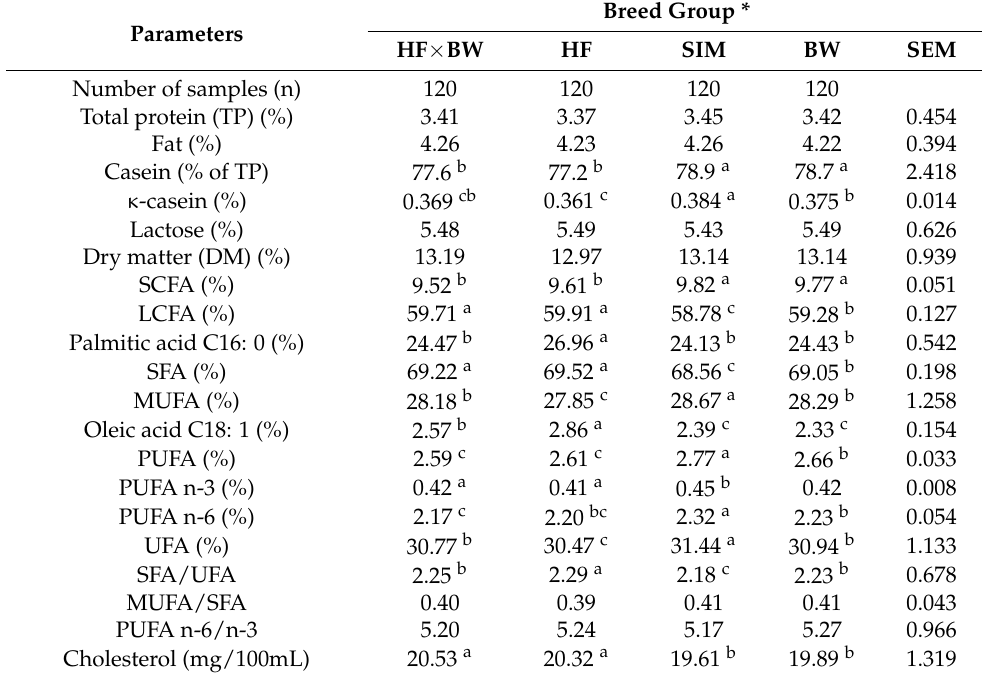
Table 3. Content of nutrients and main fatty acid fractions in the milk of the breed groups. Breed Group * Parameters HF × BW HF SIM BW SEM Number of samples (n) 120 Total protein (TP)